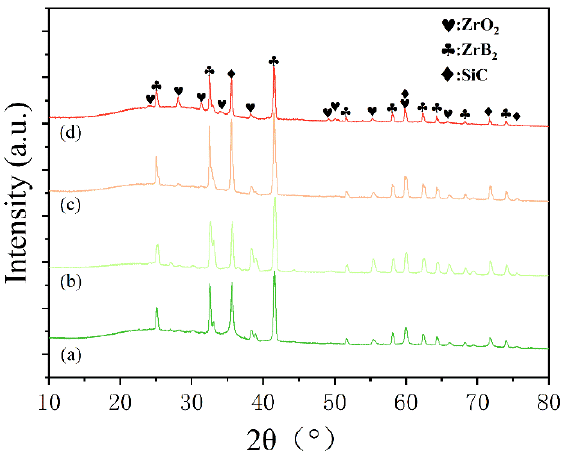
Figure 6. XRD patterns for the ablated surfaces of the composites: (a) SF-0.5; (b) SF-1; (c) SF-3; (d) SF-6.